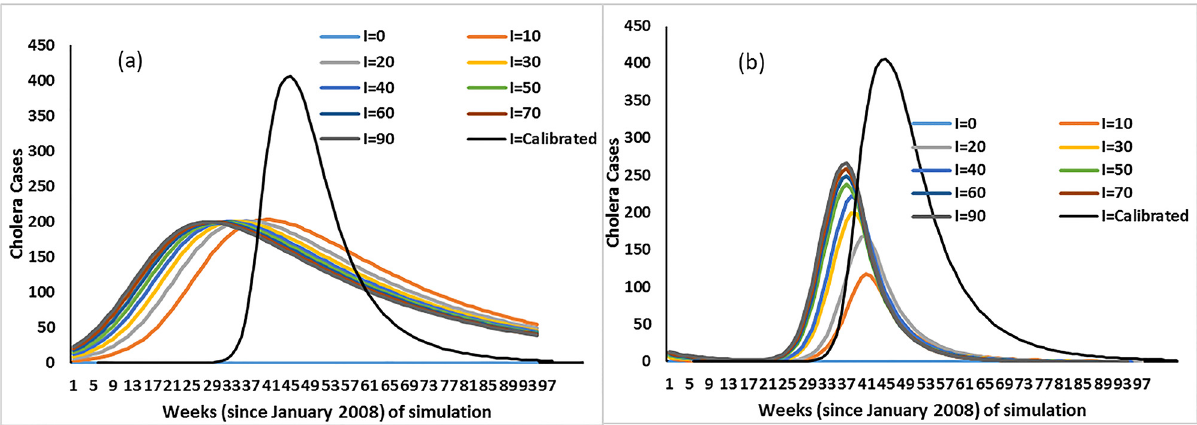
Fig 10. (a) Cholera cases with no external hydroclimatic forcing and environmental bacteria reservoir; (b) Cholera cases with external hydroclimatic forcing but with no environmental bacteria reservoir. (I = 0, 10 ... 90 indicates infected introduced in the population and I = calibrated is the simulated infected cholera cases after calibration of